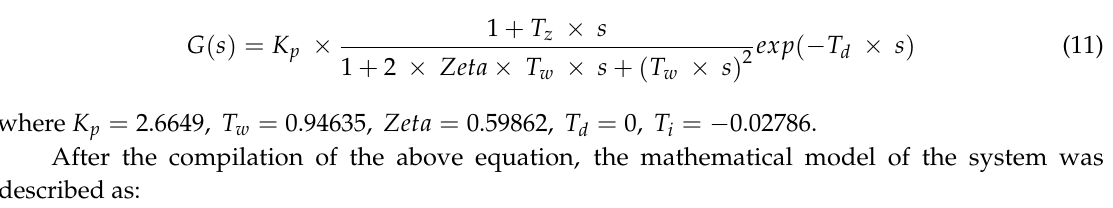
Figure 4. Result of system identification.